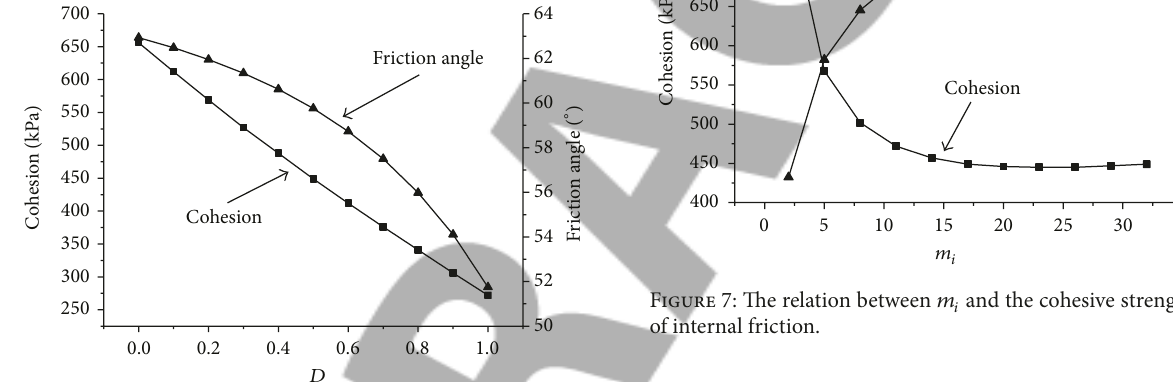
Figure 4: The relation between 𝐷 and the cohesive strength/angle of internal friction.